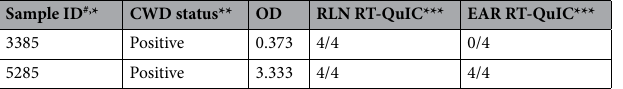
Table 1. Comparison of RLN ELISA (optical density; OD) and RT-QuIC results with ear (area 7) IOME- RT-QuIC results. *Sample numbers with a “w” suffix were from white-tailed deer; all others were from mule deer. **Based on RLN ELISA and RT-QuIC results in 3rd and 4th columns, which were 100% concordant. ***Positive/total replicate reactions. Two fractions for the same sample indicate results from repeated assays in quadruplicate. ****Carcass submitted for diagnostic examination. Samples not marked came from apparently healthy hunter-killed deer.